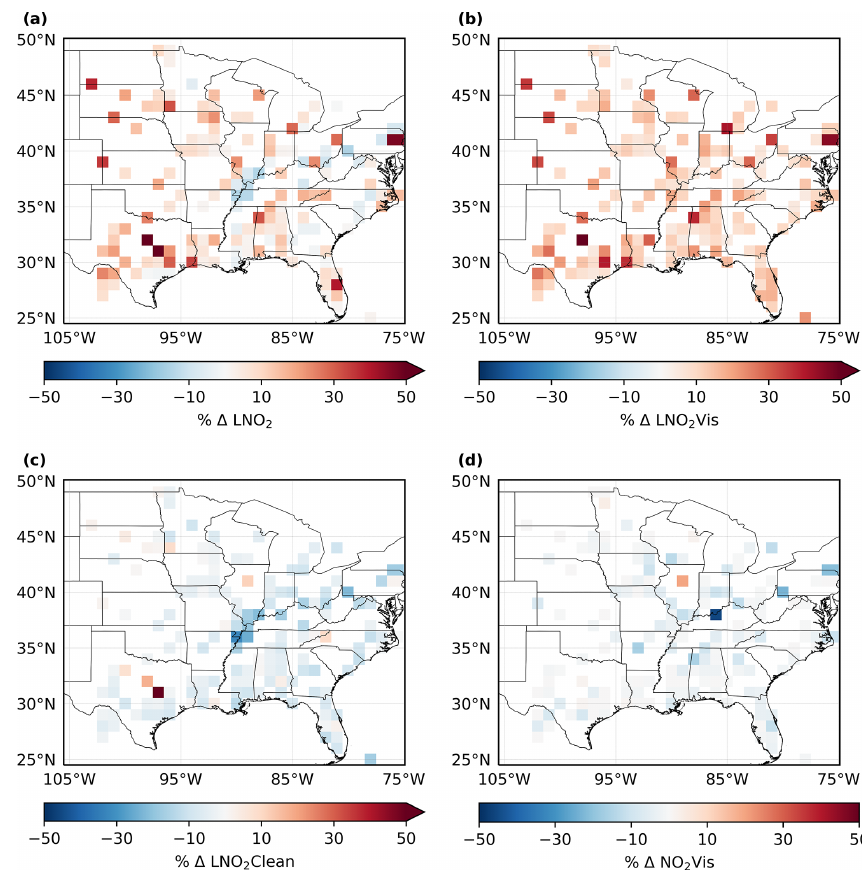
Figure 12. Average percent differences in (a) LNO 2 , (b) LNO 2 Vis, (c) LNO 2 Clean, and (d) NO 2 Vis with CRF = 100% over MJJA 2014.